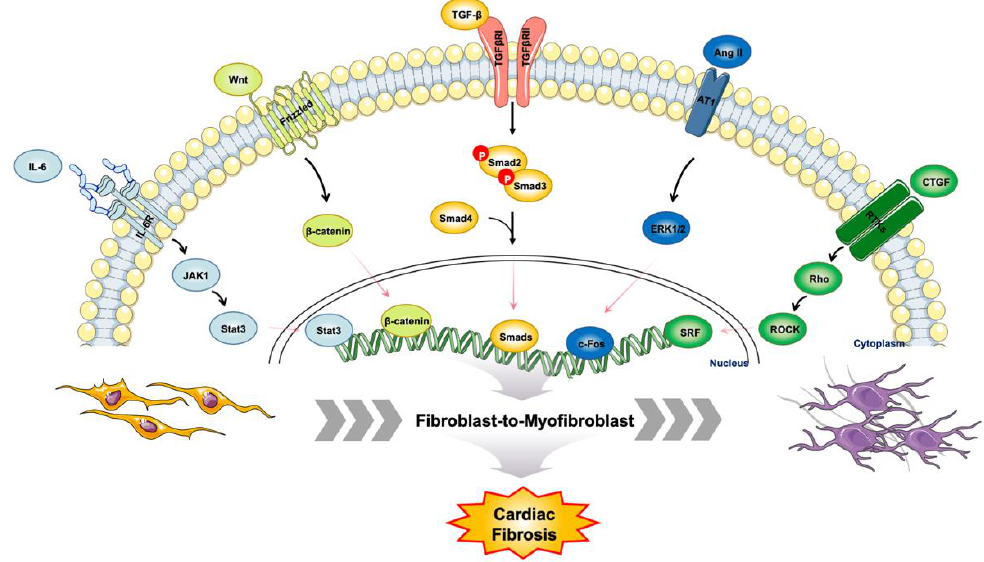
Figure 3. Cellular signaling crosstalk involved in the regulation of cardiac